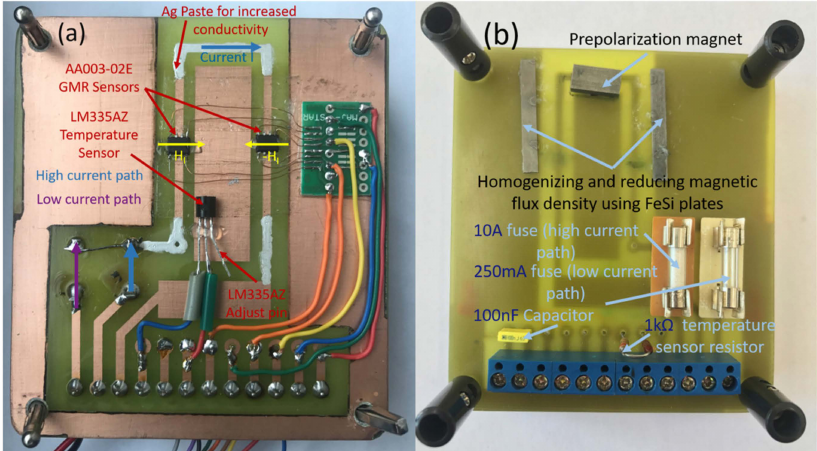
Figure 10. Custom PCB for current measurement using GMR sensors: ( a ) backside; ( b ) frontside.